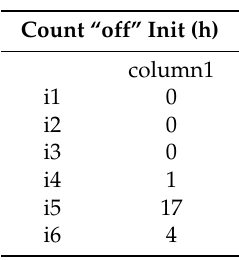
Table A6. Time periods that unit i has been down before t = 0 (h): count_off_init( i